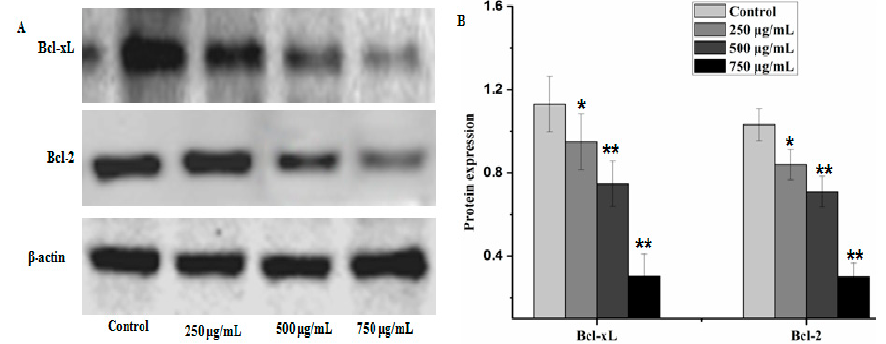
Figure 7. PZH inhibited anti-apoptotic protein Bcl-2 and Bcl-xL. The relative optical densities were indicated in B. Cells were treated with 250, 500 and 750 μ g/mL PZH for 24 h and then were lyzed for the determination of the indicated protein levels by western blot. Actin was used as internal control. * p < 0.05, ** p < 0.01 vs. control group. Data are mean ± SD. ( A ) Protein expresion of Bcl-2 and Bcl-xL, ( B ) The relative optical densities of Bcl-2 and Bcl-xL.